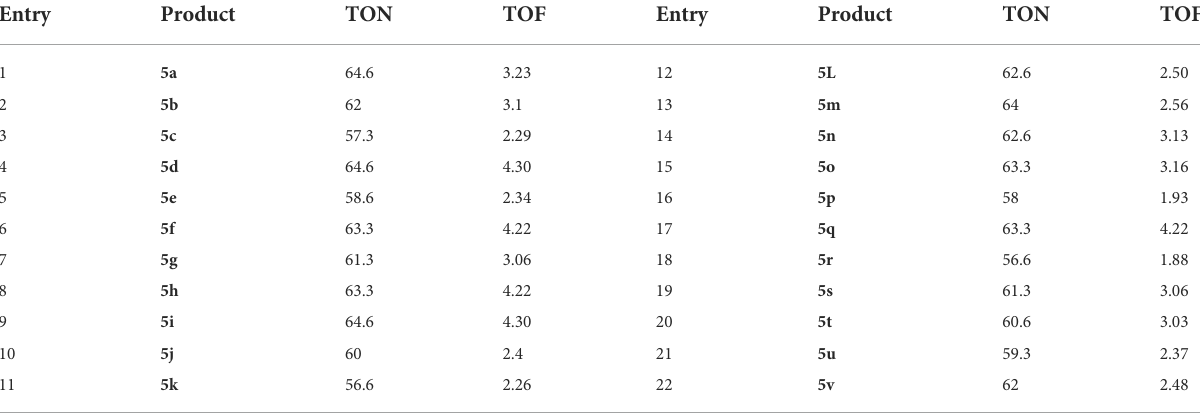
TABLE 4 For polyfunctionalized dihydro-2-oxypyrroles, the determined turnover number (TON) and the turnover frequency